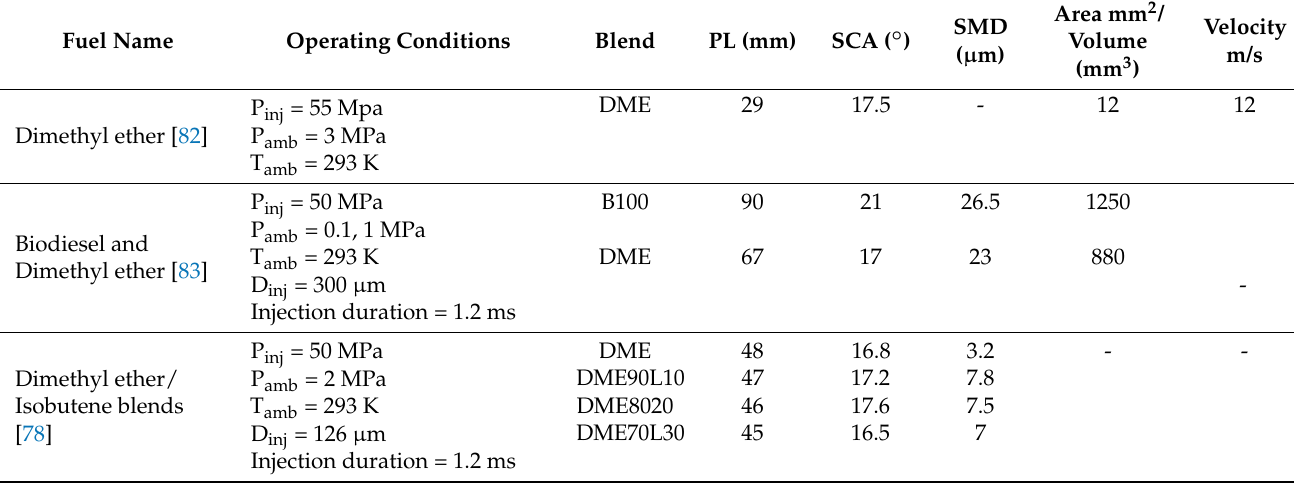
Table 4. Summary of spray properties with ether